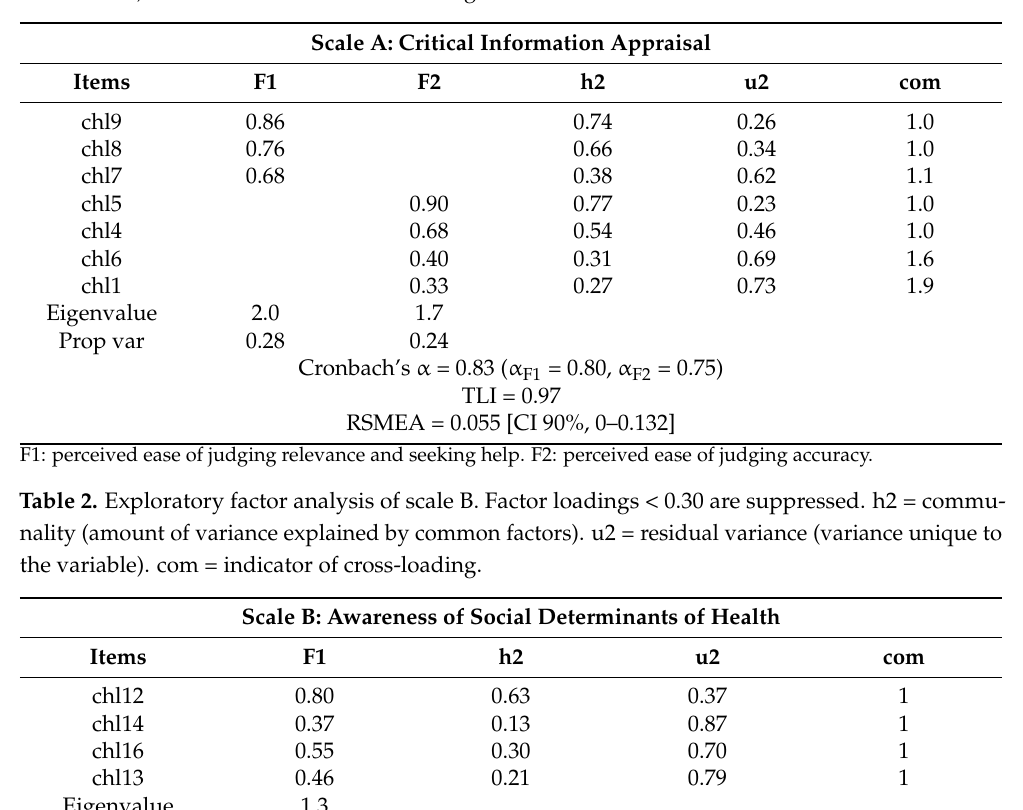
Table 1. Exploratory factor analysis for scale A. Factor loadings < 0.30 are suppressed. h2 = commu- nality (amount of variance explained by common factors). u2 = residual variance (variance unique to the variable). com = indicator of cross-loading.